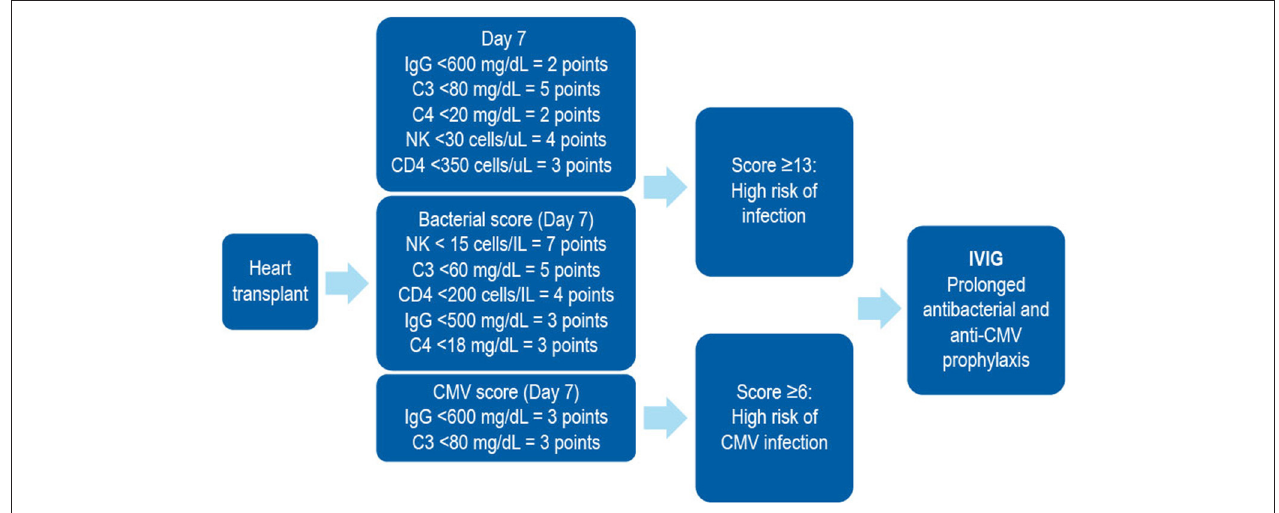
In hematological malignancy, supportive